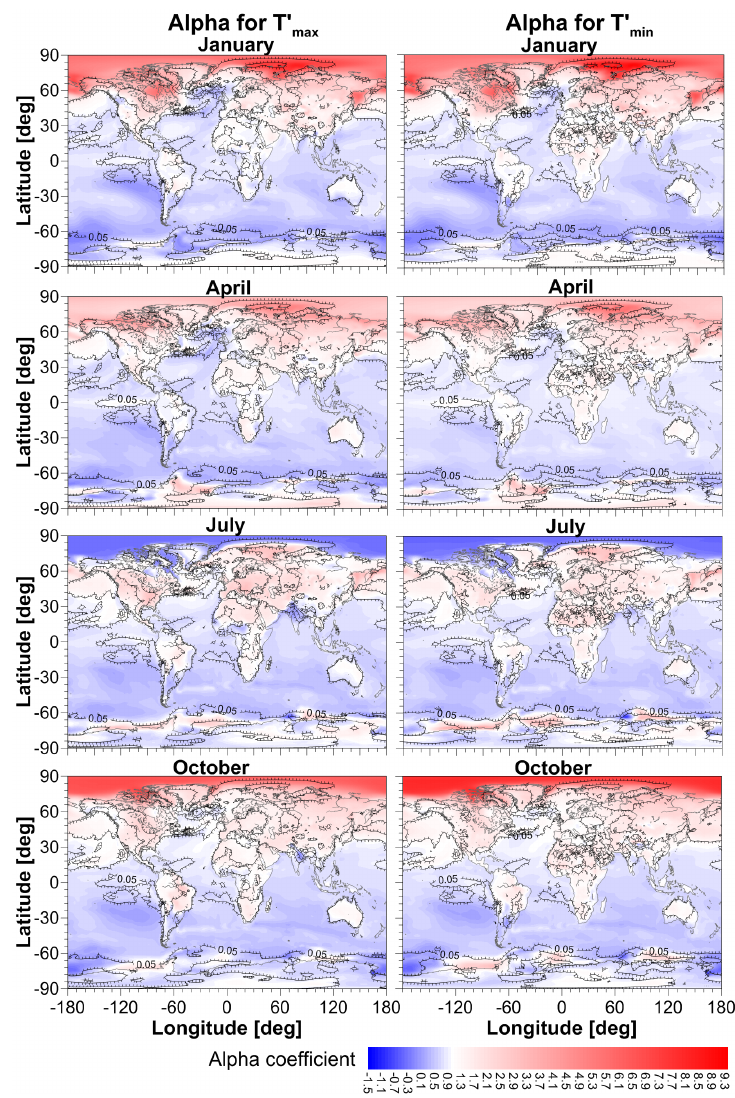
Fig. 3. Global maps of α fit-coefficients for T 0 max (left column) and T 0 min (right column) for four selected months of the year. The coefficients were obtained by fitting T 0 global (Eq. (1)) to T 0 max and T 0 min time series from the HadGEM2-ES RCP 4.5 simulation. The colour scale shows the value of α while the overlaid contours show the 1 σ uncertainties on α (hatch marks on the contours show the direction towards smaller uncertainties). Regions in red show where T 0 max and T 0 min are warming faster than the global mean surface temperature and regions in blue where they are warming slower than the global mean surface temperature and possibly even cooling (negative α values).